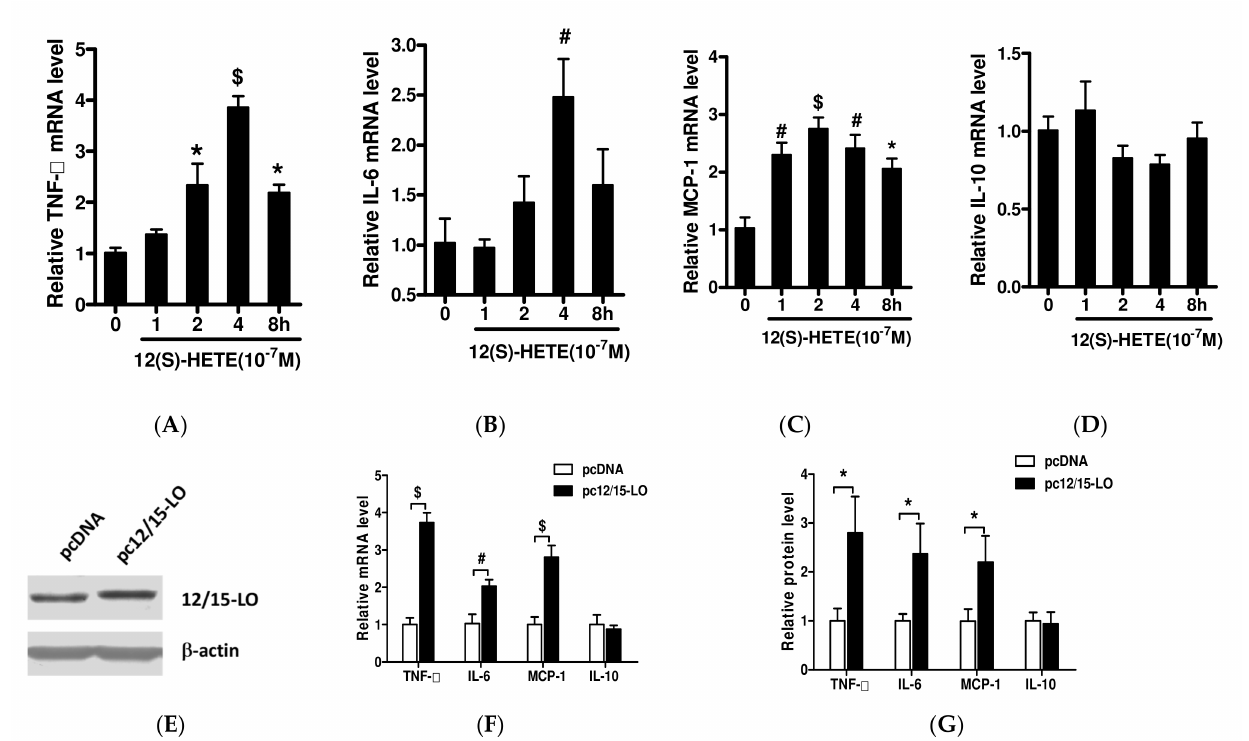
Figure 1. Effects of 12(S)-HETE on the expression of adipose inflammatory factors. MCs were stimulated with 12(S)-HETE (10 − 7 M) for 1–8 h and changes in intracellular mRNA levels of TNF- α ( A ), IL-6 ( B ), MCP-1 ( C ), and IL-10 ( D ) were measured by RT-qPCR. Results are shown as fold over non treatment control (mean ± SEM, n = 3. * p < 0.05, # p < 0.01, $ p < 0.001 vs. control). ( E ) MCs were stably overexpressing 12/15-LO protein by transfection of 12/15-LO DNA or pcDNA as control. Equal numbers of sub-confluent pcDNA and pc12/15-LO MCs were cultured in medium (RPMI1640 + 1%FBS) for 48 h. ( F ) Intracellular mRNA expression of TNF- α , IL-6, MCP-1, and IL-10 were detected by RT-qPCR. ( G ) Aliquot supernatant was collected from each Petri dish and content of TNF- α , IL-6, MCP-1, and IL-10 were measured by ELISA kits. Results are shown as fold over pcDNA (mean ± SEM, n = 3. * p < 0.05, # p < 0.01, $ p < 0.001 vs.